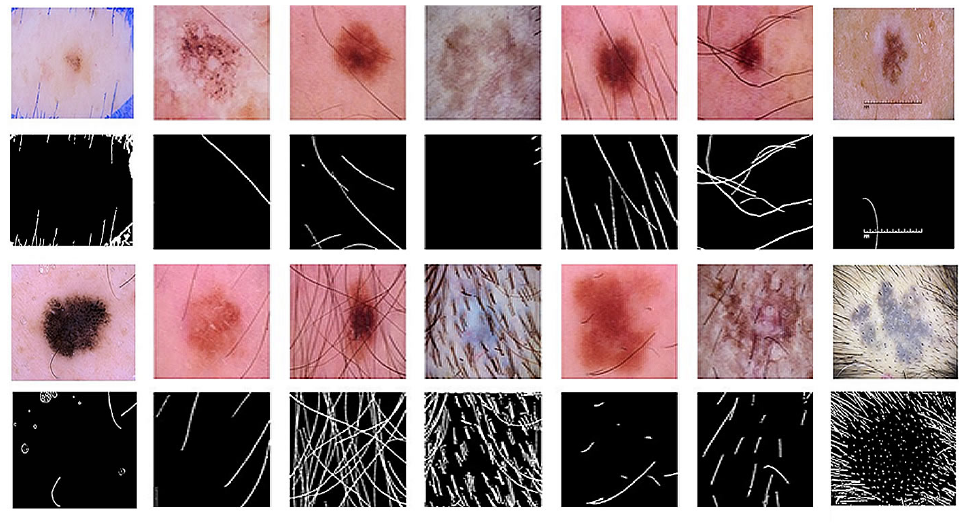
Figure 3. Examples of the cleanup